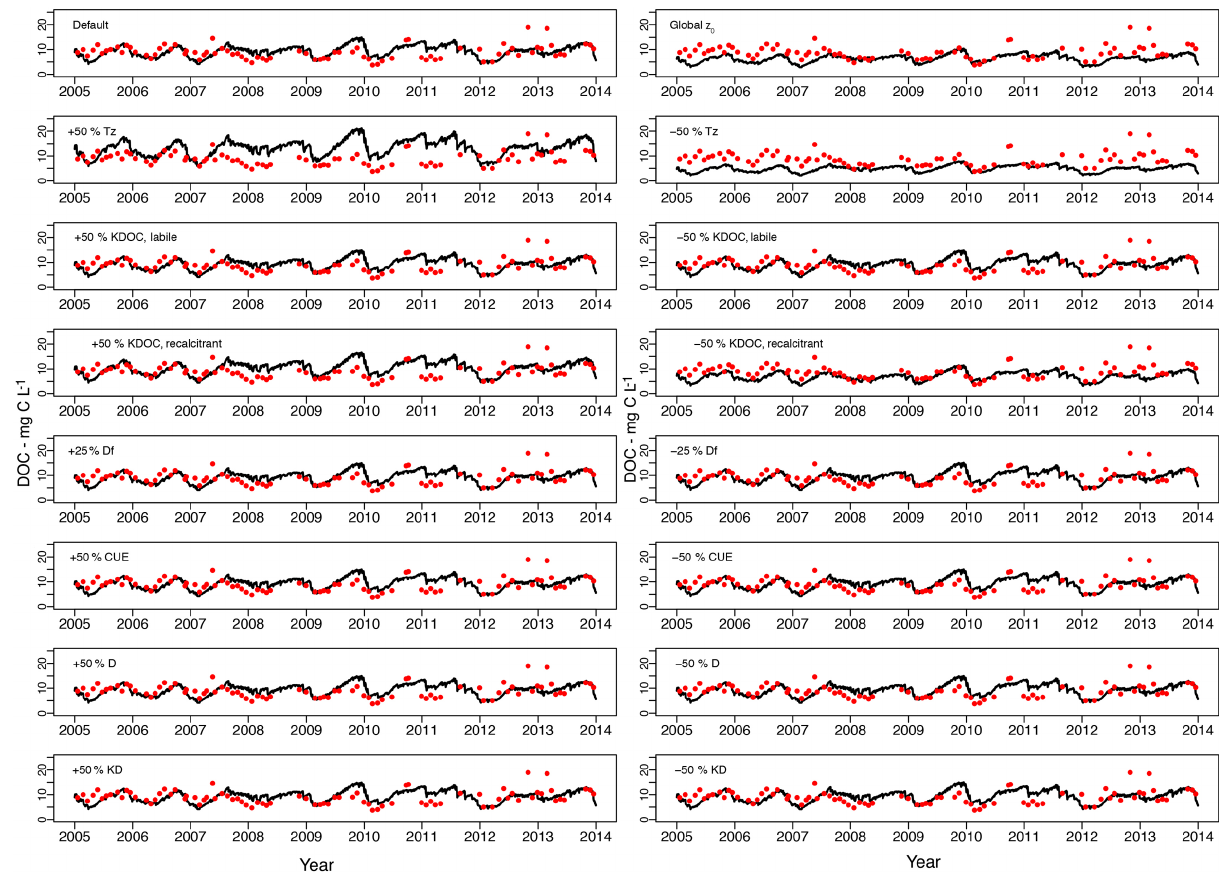
Figure 7. DOC concentration (mgCL − 1 ) simulated with sensitivity parameter sets (black line) versus measured (red dot) at 10cm of depth in Hainich for the period 2004–2013. Parameter set descriptions and values are given in Table 1. Results for other sites are given in Fig. S1.